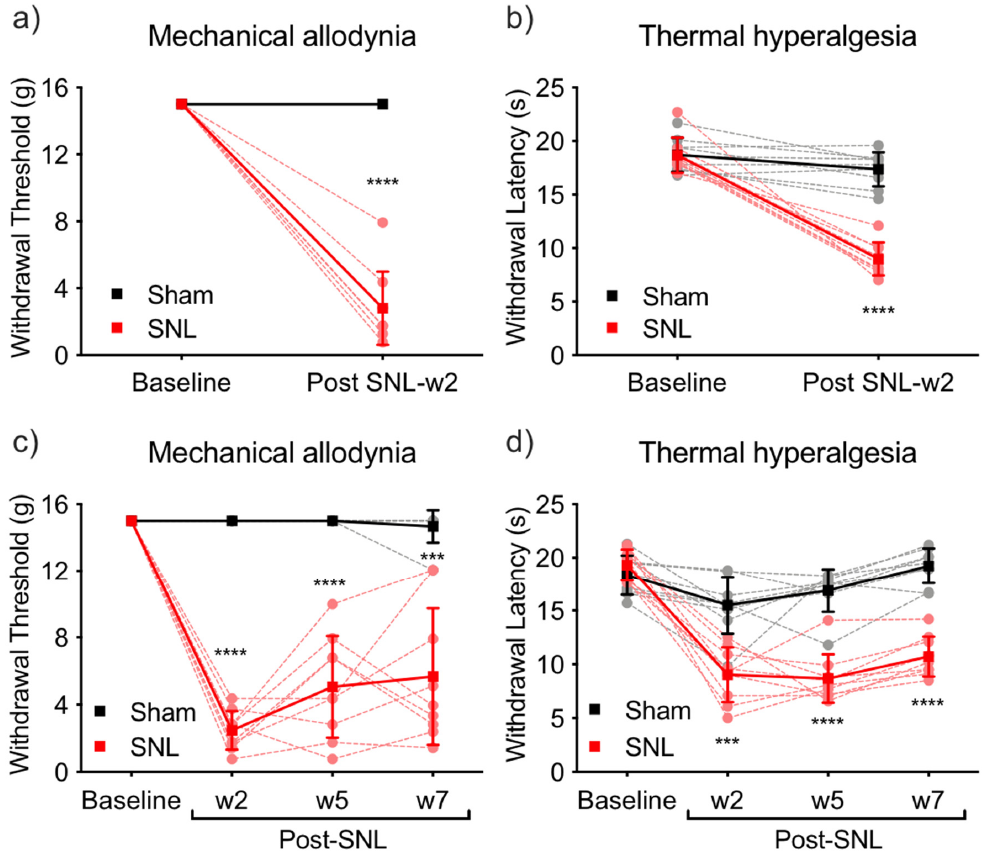
Figure 1. Mechanical and thermal responses for SNL and sham-operated rats: Pain responses of the 2 week groups (nine SNL rats and nine sham rats): ( a ) mechanical allodynia and ( b ) thermal hyperalgesia were measured at baseline (before surgery) and at 2 weeks (w2) post SNL surgery. Pain responses of the 8 week groups (nine SNL rats and nine sham rats): ( c ) mechanical allodynia and ( d ) thermal hyperalgesia were measured at baseline (before surgery) and at 2, 5, and 7 weeks post SNL surgery. Average group data with SEM and individual data are plotted as solid lines and dotted lines, respectively; *** p < 0.0005, **** p < 0.0001, compared with baseline in the same group. In another cohort of SNL and sham-operated animals, tactile allodynia and thermal hyperalgesia were evaluated at 2, 5, and 7 week timepoints after the surgery (see methods for details). The SNL group developed long-lasting tactile allodynia and thermal hyperal- gesia indicated by significant decreases from baseline in paw withdrawal thresholds and latencies at all timepoints (Figure 1c,d), while the sham-operated rats did not show decreased mechanical or thermal withdrawal responses. Two-way RM ANOVA demon- strated a significant effect of time, surgery, and interaction ( p < 0.0001 for all factors) on the thermal and tactile responses; there was a significant ( p = 0.024) effect of subject for the thermal but not tactile responses. Post hoc test demonstrated a significant difference in tactile allodynia and thermal hyperalgesia between sham and SNL groups at all timepoints (Figure 1c,d, solid lines). Every individual SNL rat except one at the 5 week timepoint had lower withdrawal threshold and lower latency than every sham-operated rat, showing the clear group separation (Figure 1c,d, dotted